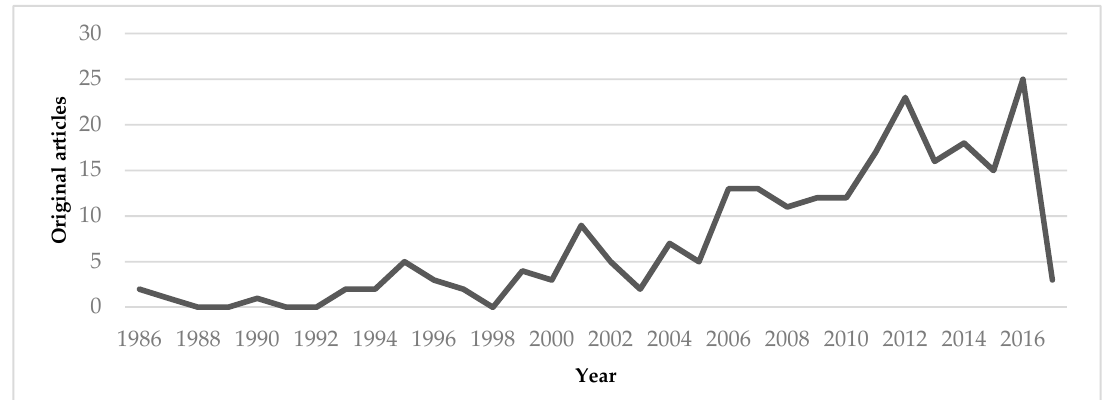
Figure 3. Distribution of results by year of publication.